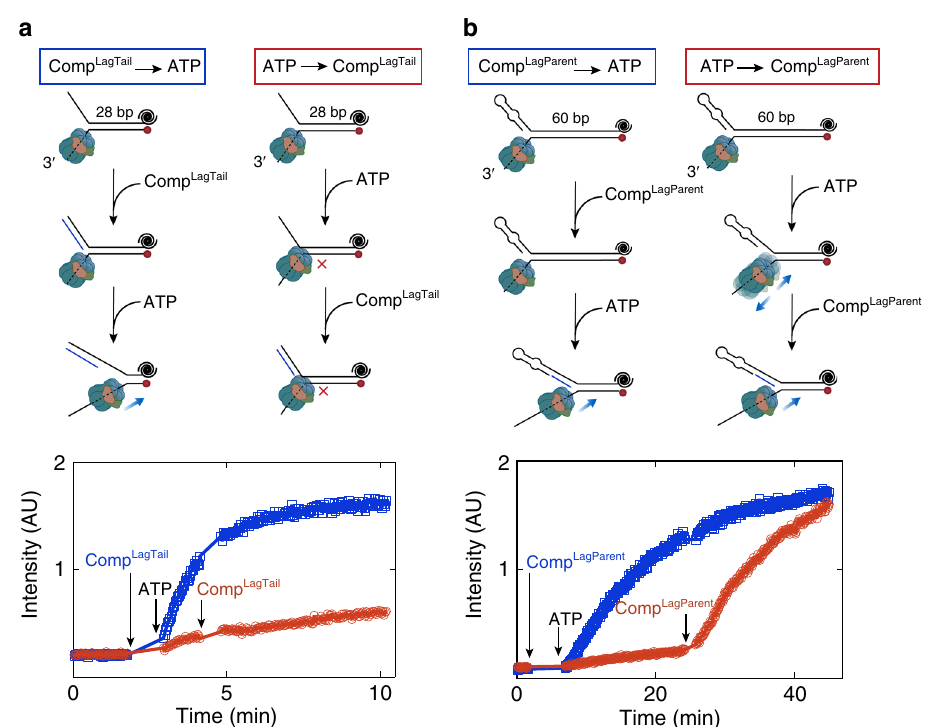
Fig. 6 DNA reannealing can free CMG from the duplex-engaged state. a Single-turnover unwinding of fork DNA with a single-stranded lagging-strand arm and 28 bp parental duplex. CMG was bound to the fork in the presence of ATP γ S. Subsequently ATP was added and unwinding was monitored through Cy5 fl uorescence. An oligonucleotide complementary to the lagging-strand arm (Comp LagTail ) was added either before (blue, Comp LagTail → ATP) or 2 minutes after (red, ATP → Comp LagTail ) ATP. b Single-turnover unwinding of fork DNA with d(GGCA) 10 lagging-strand arm and 60-bp parental duplex. CMG was bound to the fork in the presence of ATP γ S. Subsequently ATP was added and unwinding was monitored through Cy5 fl uorescence. An oligonucleotide complementary to the lagging-strand template within the 60-bp parental dsDNA (Comp LagParent ) was added either before (blue, Comp LagParent → ATP) or 20 minutes after (red, ATP → Comp LagParent ) ATP. Source data are provided as a Source Data fi ATP (Fig. 6b, ATP → Comp LagParent , red). To determine whether this stimulation is owing to the suppression of unwound DNA strands rehybridizing behind the helicase, we tested the impact of an oligonucleotide complementary to the leading-strand template within the parental duplex (Comp LeadParent ) on unwinding. The increase in DNA unwinding by Comp LeadParent was signi fi cantly lower than that by Comp LagParent (Supplementary Fig. 6), indicating that increased helicase activity by Comp LagParent cannot be solely ascribed to an inhibition of fork DNA reannealing in the wake of CMG. Together, the data are consistent with the notion that if the parental duplex invades into the CMG central channel, reannealing of DNA ahead of the helicase can liberate CMG from this inactive fork-binding mode by promoting backwards translocation.